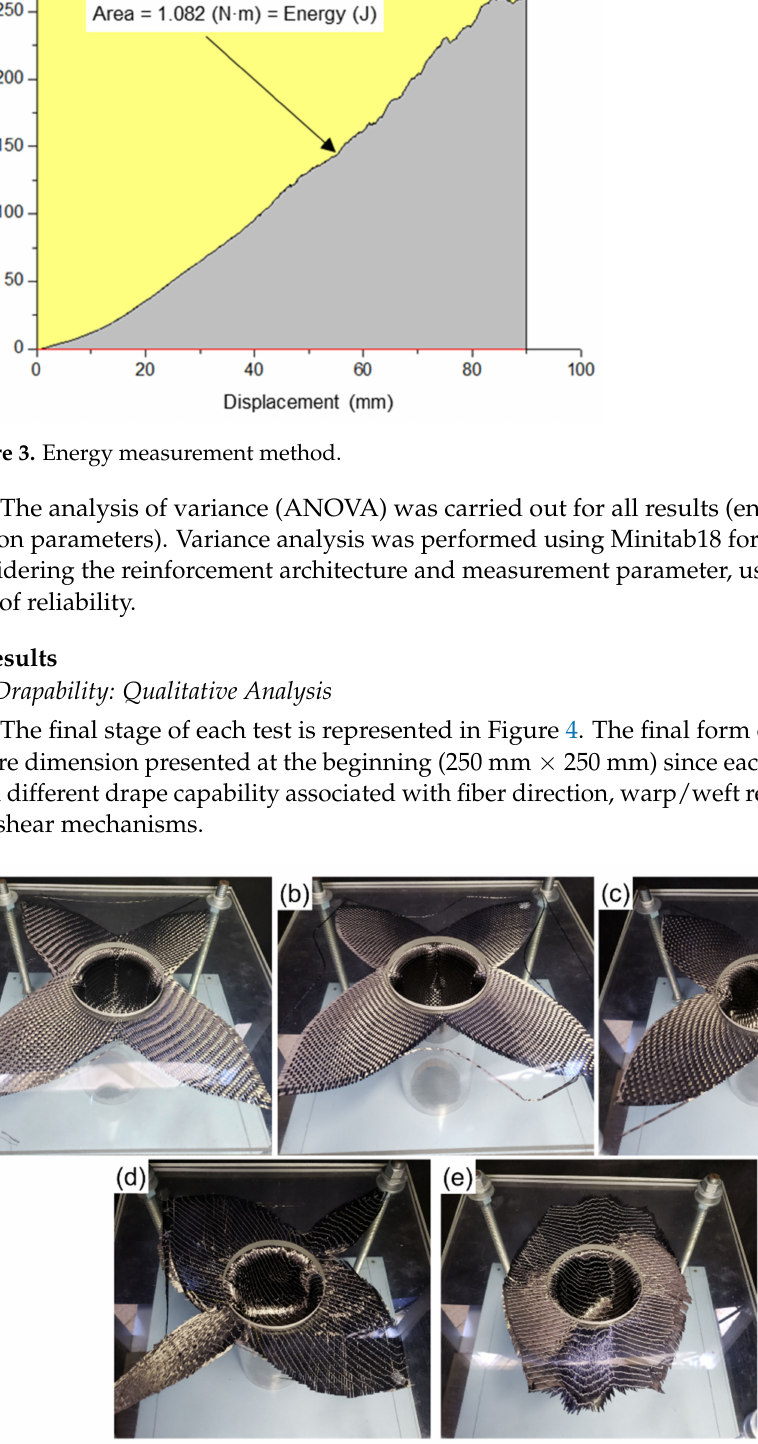
Figure 4. Reinforcement form at the end of the test: ( a ) plain; ( b ) twill; ( c ) satin; ( d ) NFC 0/90, and ( e ) NCF ±